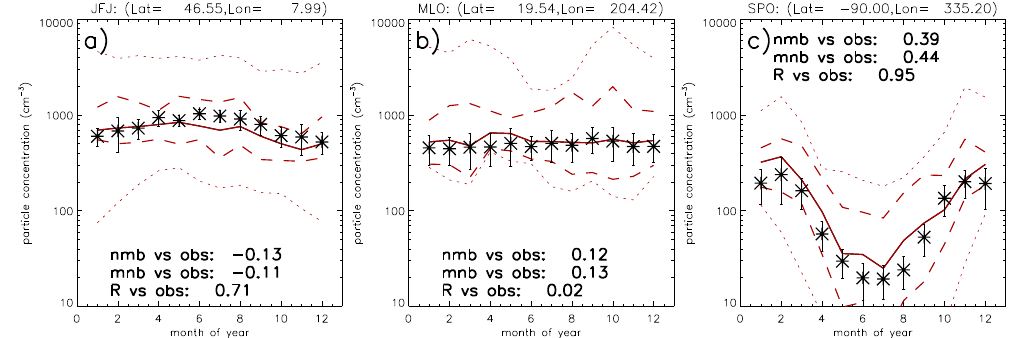
Figure 7. Simulated annual cycle in surface N(D p > 10nm/14nm) against CPC observations at free troposphere GAW sites Jungfraujoch (10nm), Mauna Loa (10nm) and South Pole (14nm). The solid line is the geometric mean over the central two-thirds of models in each month, with the dashed lines the minimum and maximum over those central-8. The dotted line shows the minimum and maximum over all 12 models. The error bars on the observations indicate the standard deviation over the several years of data shown in Table 3.